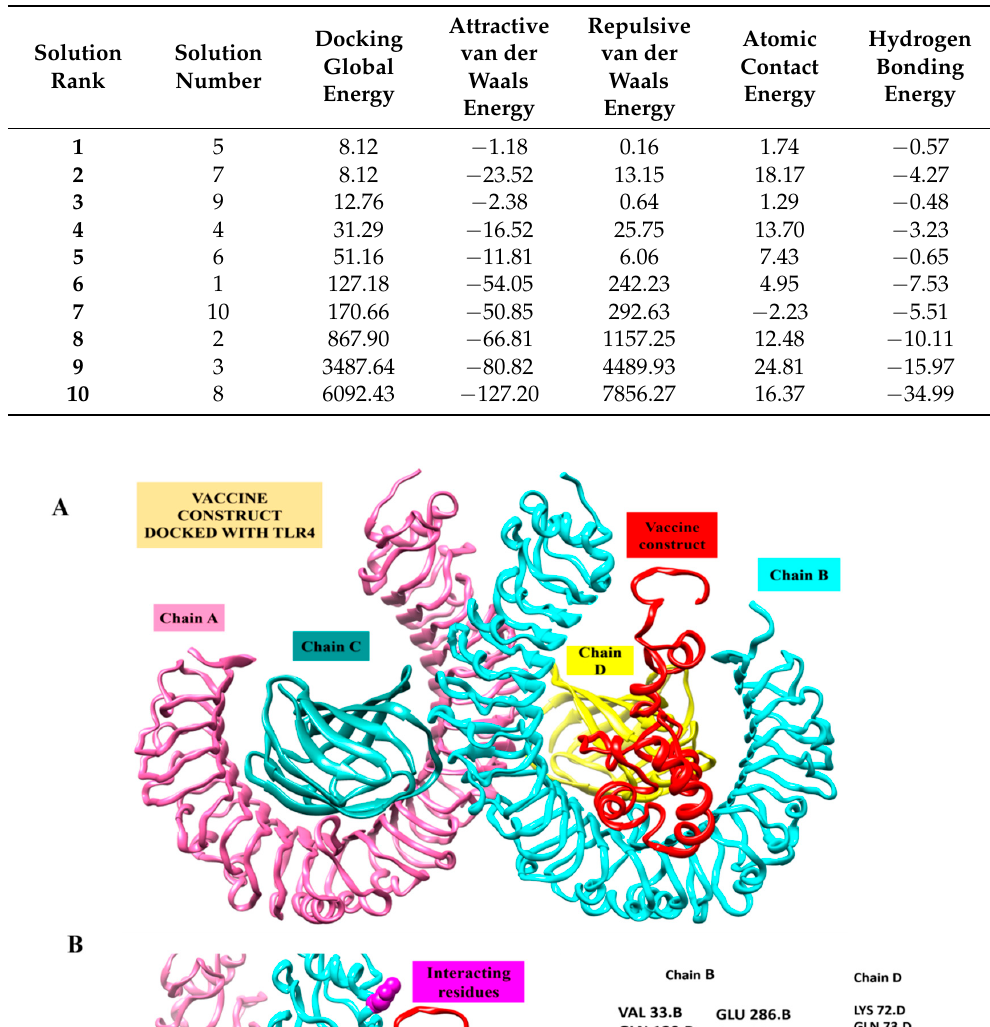
Table 4. Refined PatchDock complexes as an outcome of FireDock assay.